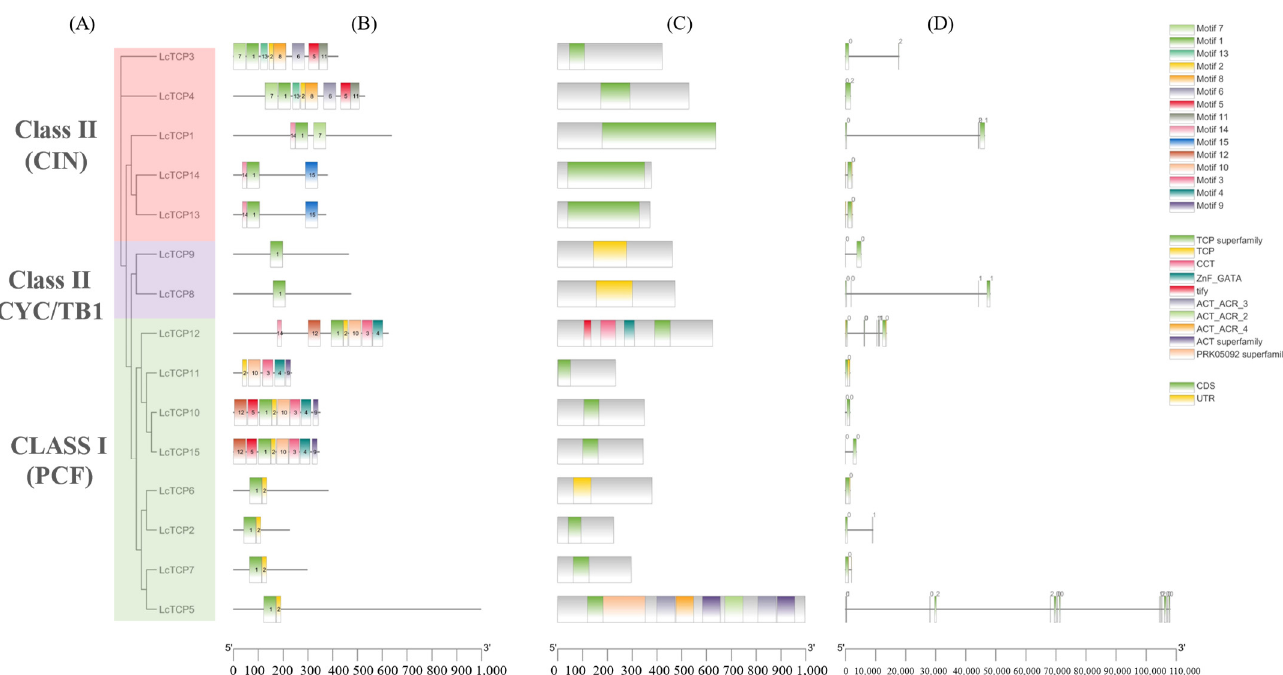
Figure 3. Gene structure and composition of TCP genes in L. chinense . ( A ) Phylogenetic relationship of LcTCPs constructed using Mega11 software. Different color backgrounds show different clades and subclades. ( B ) Motif composition of the LcTCPs, denoted by various colors, as described in the key top right corner. ( C ) Conserved Domain arrangement within the LcTCP proteins, each conserved domain is depicted by a different color scheme as shown in the key, second from the top. ( D ) Exon-intron organization on each LcTCP gene, represented by two colors, green and yellow, depicting CDS and UTR locations,